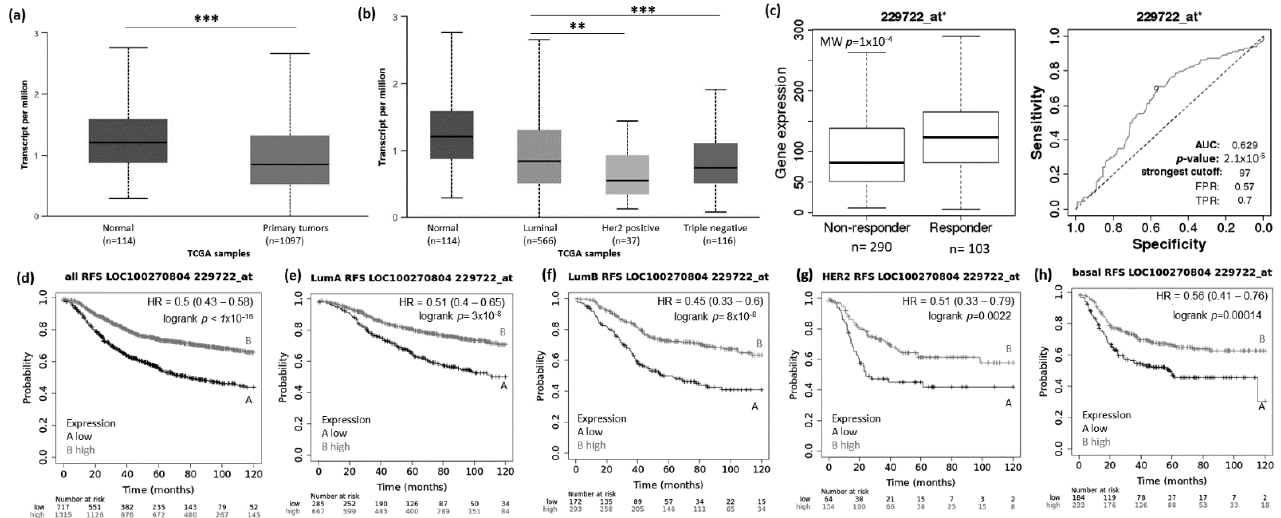
Figure 4. LOC100270804 lncRNA expression in breast cancer patients and association with taxane treatment response and prognosis. Expression of LOC100270804 lncRNA in breast cancer comparing to normal breast tissue ( a ) and among different breast intrinsic subtypes using the UALCAN database containing TCGA data ( b ). ( c ) LOC100270804 lncRNA expression in groups of responder and non-responder breast cancer patients treated with taxane using the online platform ROCplot. ( d – h ) Kaplan–Meier curves for relapse-free survival of breast cancer patients for all subtypes ( d ) or for each intrinsic subtype as luminal A ( e ), luminal B ( f ), HER2 ( g ) and basal ( h ) grouped as high or low expression of LOC100270804 according to the best cut-off value using the JetSet best probe set at the KMplotter online tool. ** p < 0.01, *** p < 0.001; MW—Mann–Whitney test.